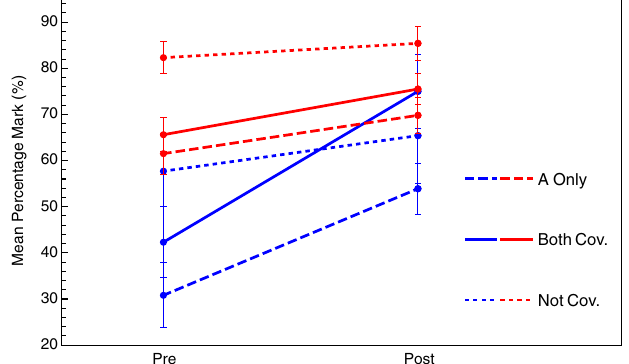
FIG. 5. Mean physics pre- and post-test scores for FSM (blue lines) and non-FSM (red lines) students, for each level. A Only (dashed lines) refers to the questions that were A Level difficulty (questions 2, 5, 6, and 8). Both Cov. (solid lines) refers to the questions that were both GCSE and A Level difficulty, and were covered (questions 1, 4, 7, and 10), while Not Cov. (dotted lines) refers to those that were not covered at all (questions 3 and 9). Errors bars denote the standard error of the